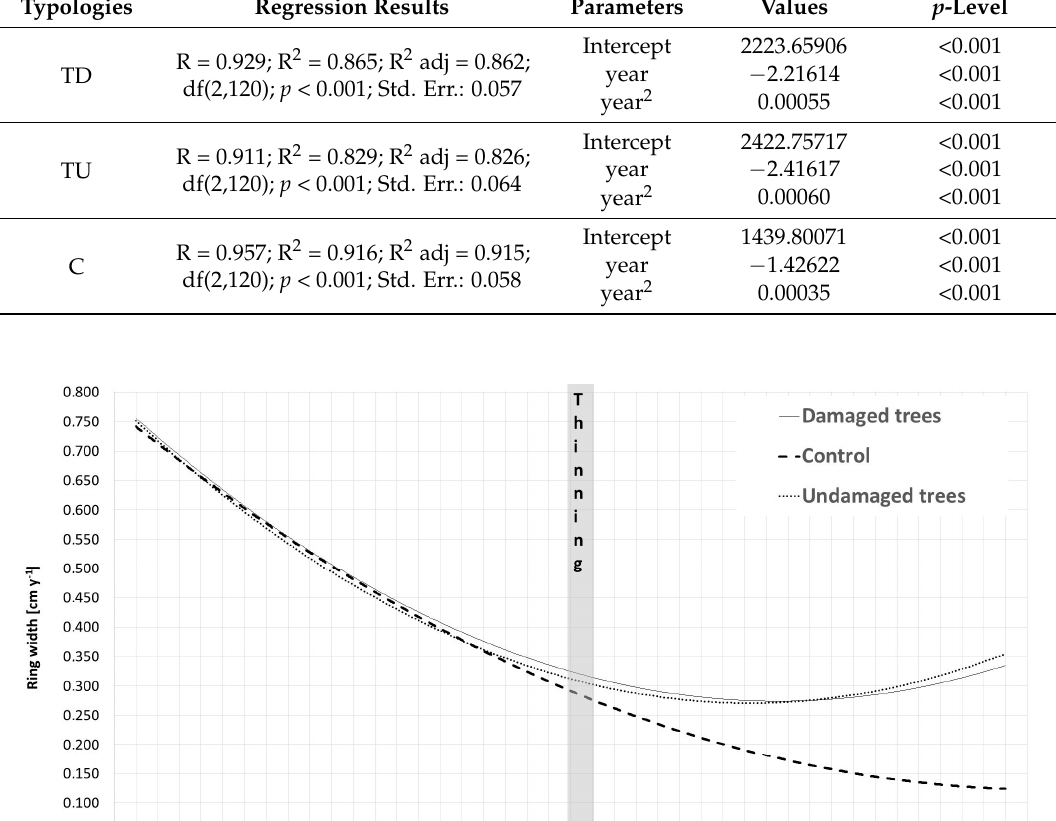
Figure 3. Non-metric multidimensional scaling (NMDS) of the average ring width per diameter class for the trees in the control area C (green polygon, N. = 5 plots, 7 diameter classes, 2 stem core samples = 70), for damaged trees TD (violet polygon, N. = 25 plots, 7 diameter classes, 1 stem core samples = 175), and for undamaged trees TU (red polygon, N. = 25 plots, 7 diameter classes, 1 stem core samples = 175) in the thinned area. The analysis is focused on a specific time period post thinning, from 1998 to 2008 (ten rings—TPT1).